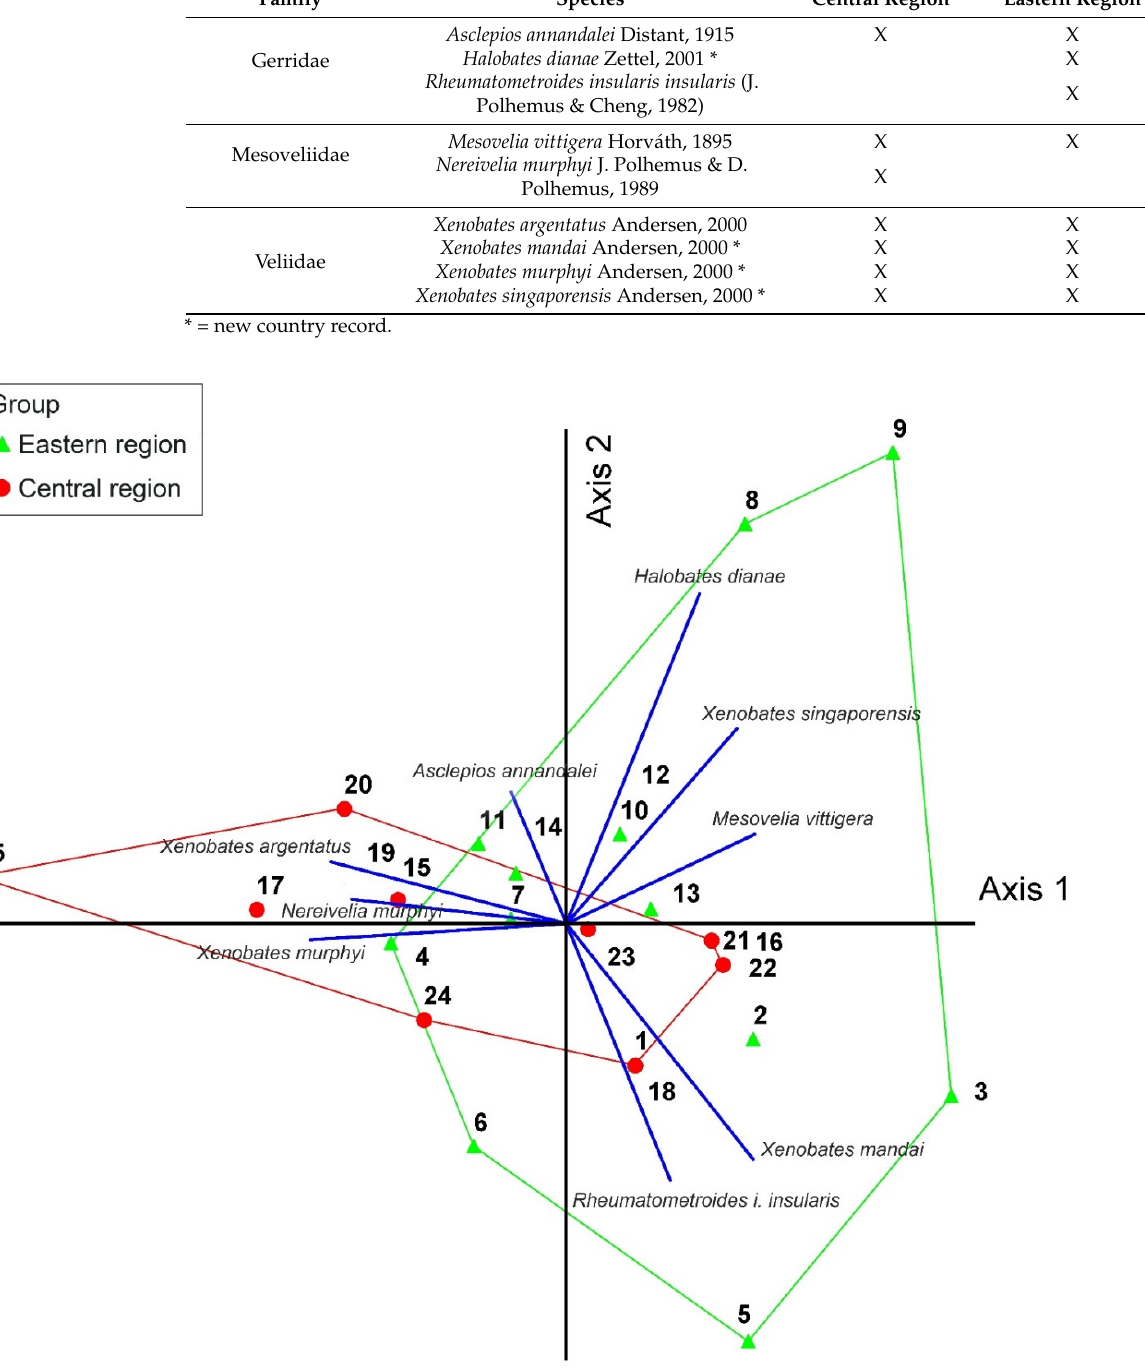
Table 2. Checklist of Gerromorpha taxa found in this study. Family